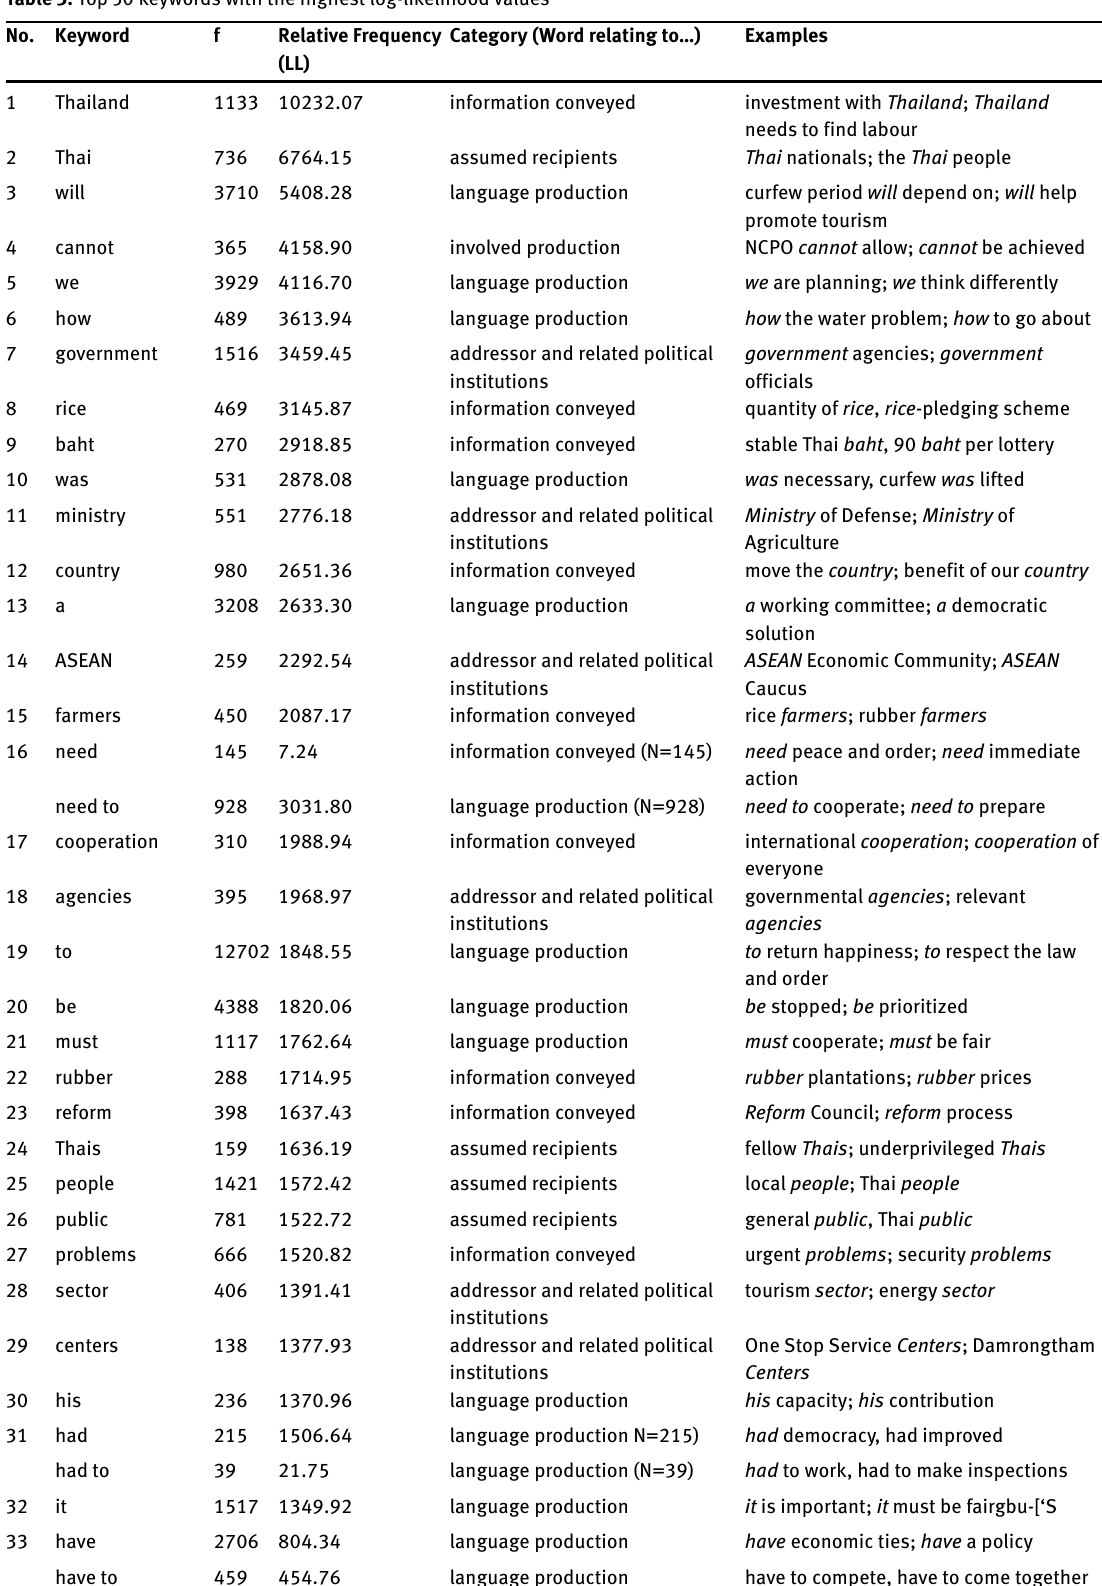
Table 3. Top 50 keywords with the highest log-likelihood